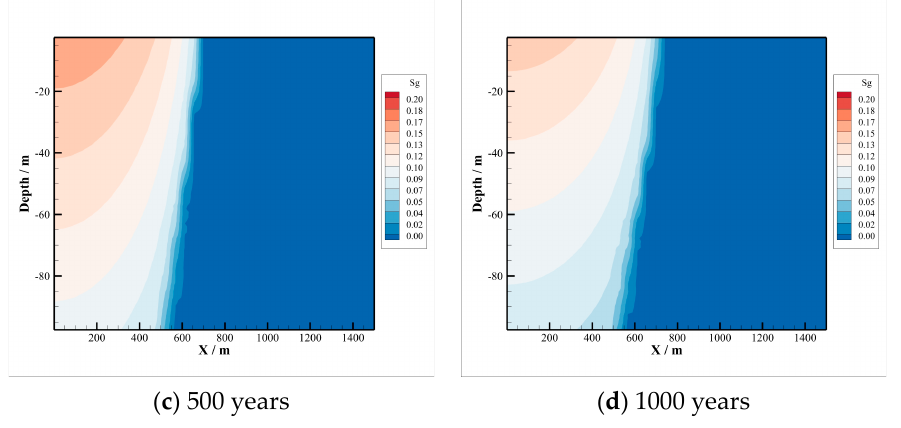
Figure 2. Sg since CO 2 injection.